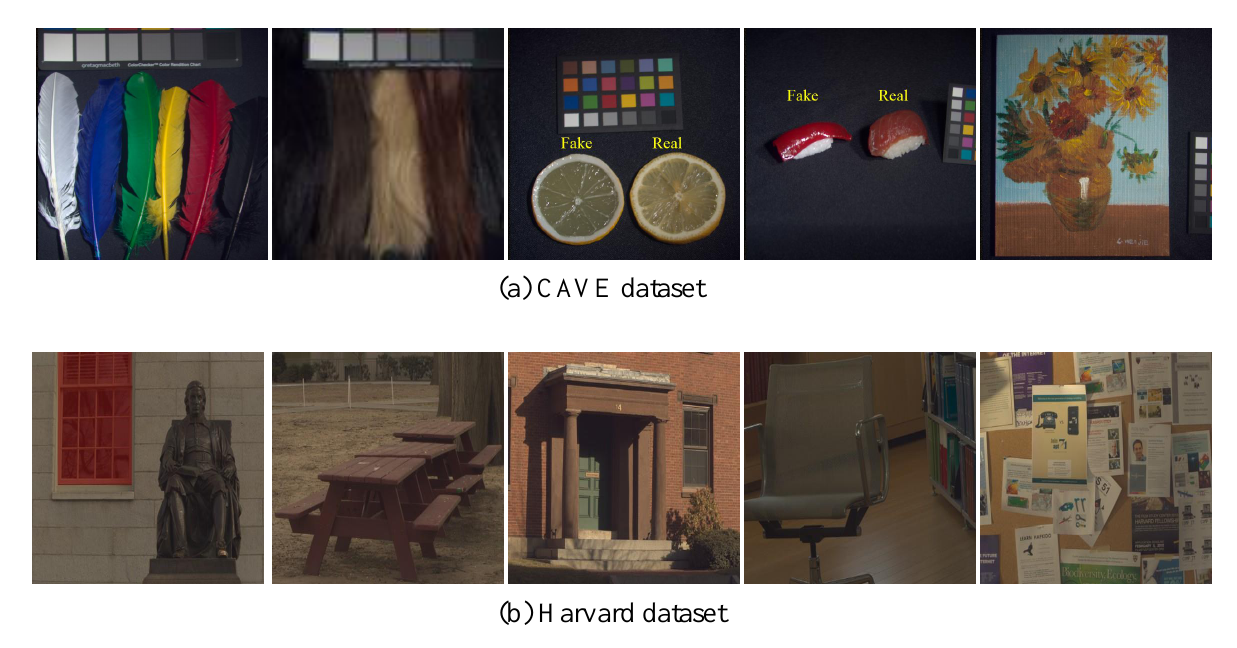
Figure 2. Example images in the CAVE and Harvard